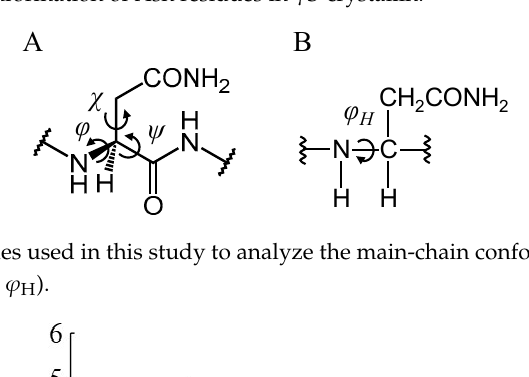
Figure 3. Conformation of Asn residues in γ S-crystallin. ( A ) Experimentally determined structure of γ S-crystallin. ( B – E ) Conformation of Asn residues in γ S-crystallin.